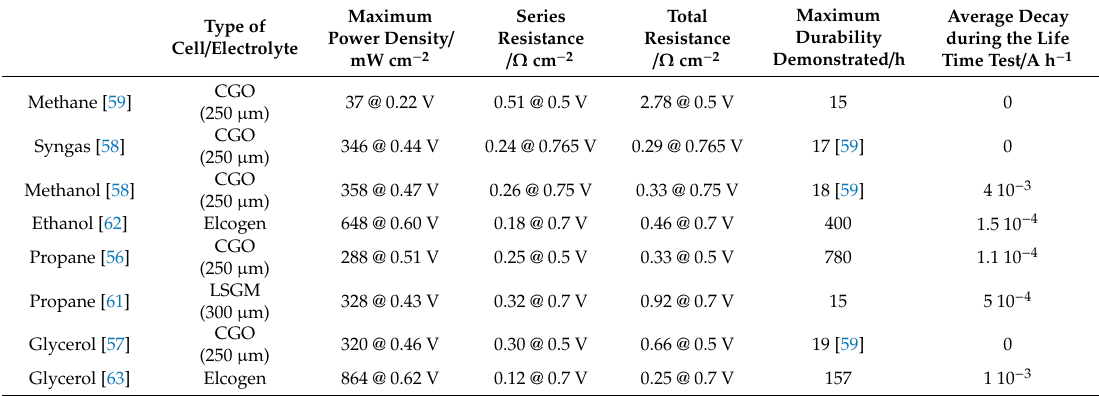
Table 2. Resume of the most important results of the electrochemical tests carried out at 800 ◦ C with di ff erent organic fuels. Data from